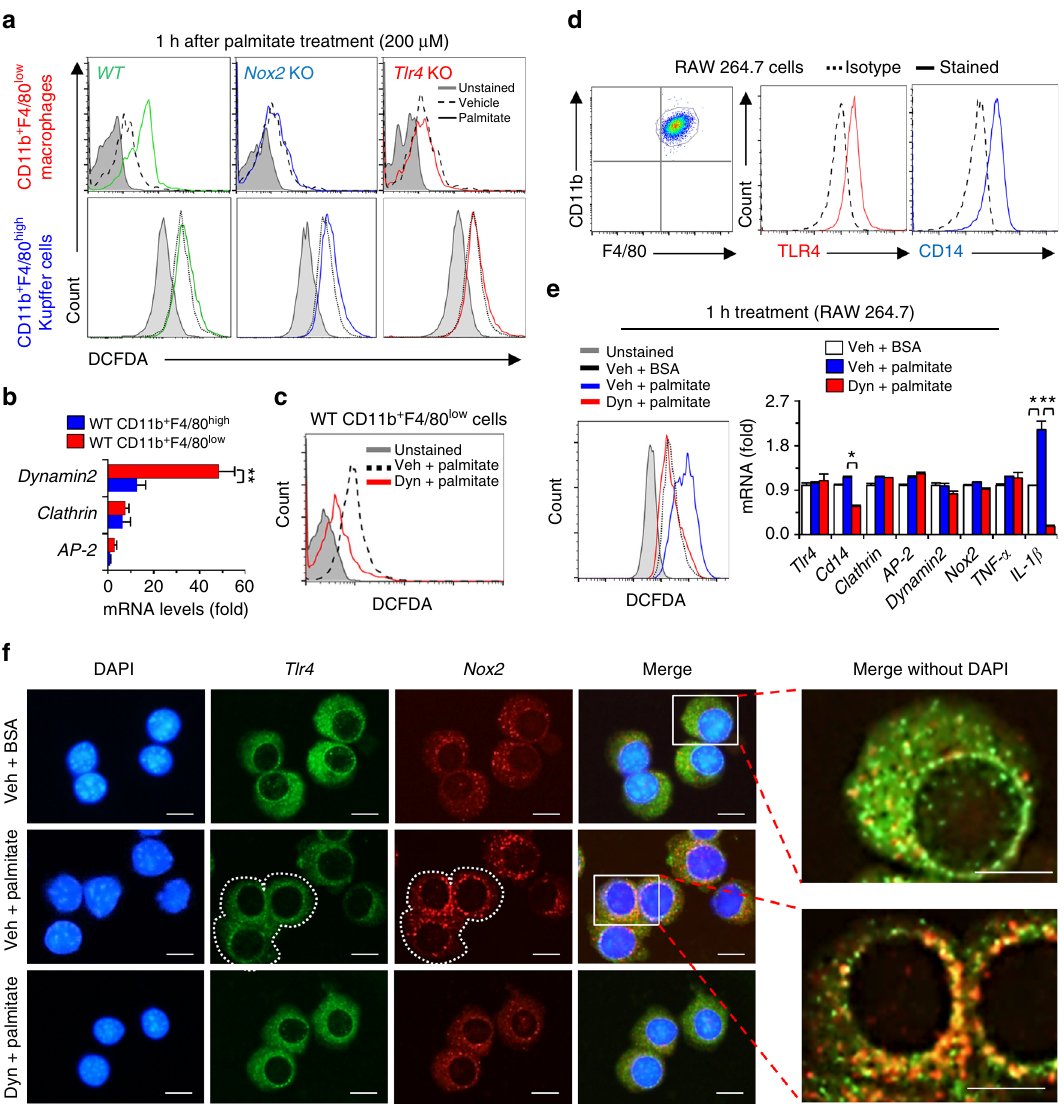
Fig. 4 Palmitate treatment increases ROS generation in CD11b + F4/80 low macrophages in TLR4 and NOX2-dependent manners. a Palmitate-mediated generation of reactive oxygen species (ROS) was monitored by DCF fl uorescence in freshly isolated CD11b + F4/80 high Kupffer cells and CD11b + F4/80 low macrophages of WT , Nox2 knockout (KO) and Tlr4 KO mice. b Freshly isolated macrophages and Kupffer cells of WT mice were subjected to quantitative real-time PCR (qRT – PCR) analyses. c Isolated macrophages of WT mice were treated with palmitate with or without dynasore (Dyn) treatment. d RAW 264.7 macrophages were subjected to fl ow cytometry analyses. e , f RAW 264.7 macrophages were treated with palmitate (200 μ M) ± dynasore (80 μ M) for 1 h. Then, these cells were subjected to ROS generation assays, qRT – PCR analyses and immunostaining with antibodies of TLR4 and NOX2. Bar = 10 μ m. Dotted white line indicates cell boundaries. Solid white rectangles are magni fi ed. Data are representative of three independent experiments in vitro using isolated liver immune cells from 3 ( a – c ) mice per group. Data are expressed as the mean ± s.e.m. and analyzed by Student ’ s t -test or one-way analysis of variance, * P < 0.05, ** P < 0.01 in comparison with the corresponding (hTLR4 – MD2) complex was eluted around the 14 ml fraction hTLR4 – MD2 complex was further incubated with palmitate compared with controls such as thyroglobulin, γ -globulin, conjugated with bovine serum albumin (BSA) or BSA only. ovalbumin, myoglobin, and vitamin B12, indicating the forma- Consistent with C-16 BODIPY, incubation with palmitate-BSA or tion of a stable monomeric TLR4 – MD2 complex (~90 kDa, 1:1) BSA did not induce dimerization of the hTLR4 – MD2 complex (Fig. 6a). After incubation with LPS Ra, a signi fi cantly forward- (Fig. 6d, e). These data suggest that unlike LPS binding to a shifted peak at the 12 ml fraction was identi fi ed as dimerized dimerized TLR4 – MD2 complex, palmitate binds to a monomeric hTLR4 – MD2 complex, whereas the unbound monomeric TLR4 – MD2 complex and may initiate the subsequent inter- hTLR4 – MD2 complex was eluted at the 14 ml fraction (Fig. 6b). nalization of the TLR4 – MD2 complex along with NOX2 for ROS Surprisingly, the hTLR4 – MD2 complex incubated with C16- generation (Fig. 6f). BODIPY remained as a monomeric complex (eluted at 14 ml), despite its tight binding to C16-BODIPY, which was con fi rmed by fl uorescence signal and Commassie staining on Native PAGE (Fig. 6c). To exclude unexpected binding of C16-BODIPY, the